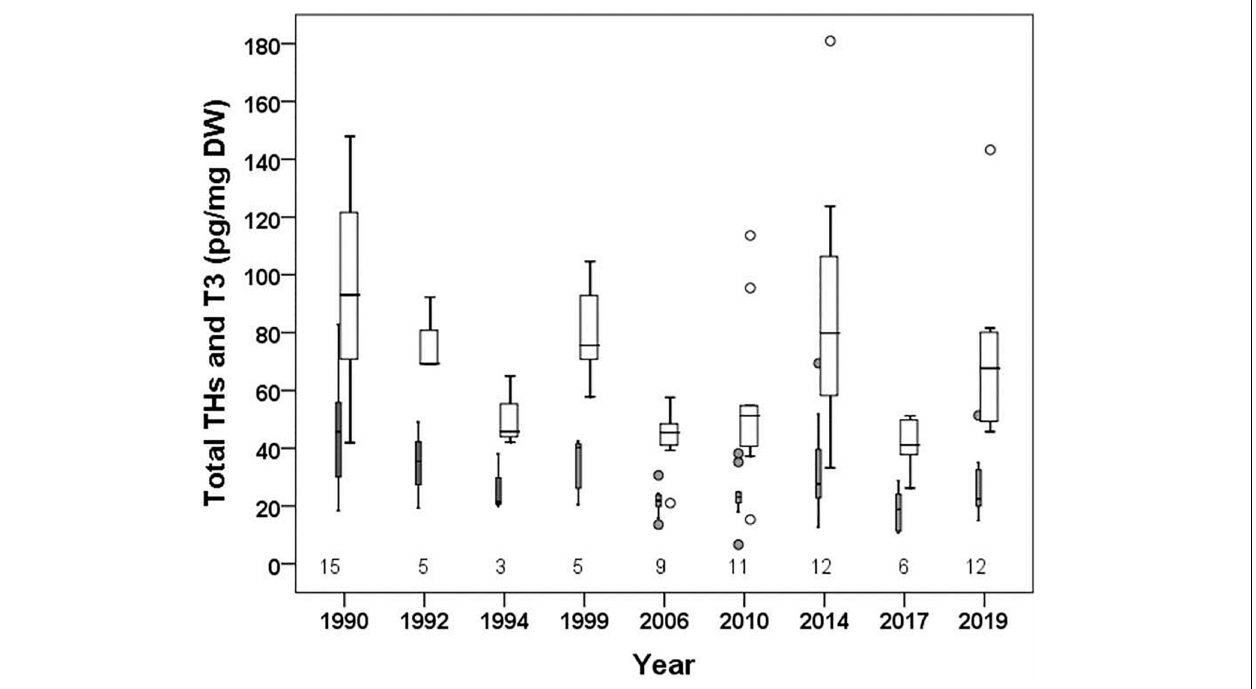
FIGURE 5 | Box-plots showing the mean concentration of thyroid hormones (Total THs, pg mg − 1 DW; broad white box) and triiodothyrenine (T3, pg mg − 1 DW; narrow gray box) in the ovarian tissue of the spawning Baltic herring during 1990–2019. The number of females analyzed per year is indicated under the box-plots in the